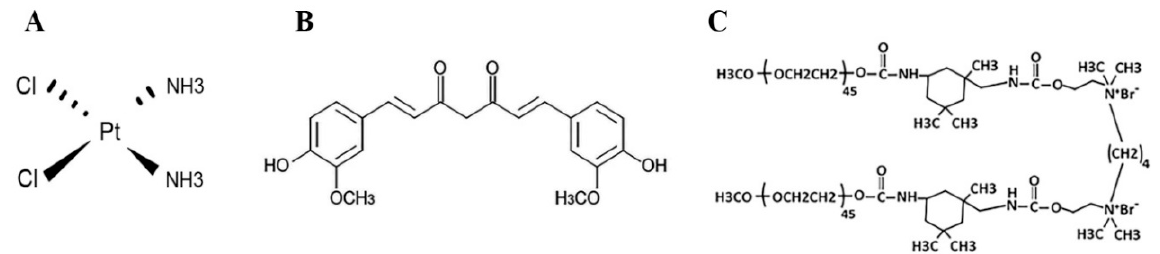
Figure 1. The molecular structure of ( A ) Cisplatin ( B ) Curcumin and ( C ) mPEG urethane gemini surfactant nanoparticle.